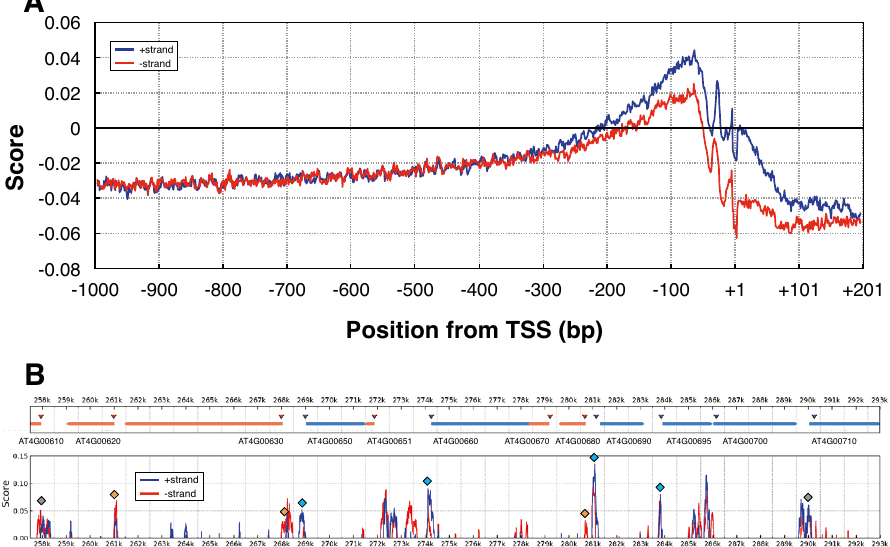
Figure 3. PRI along the promoter region. ( A ) Average of 21,393 Arabidopsis promoters for protein-coding genes for both strands (+ and −). ( B ) A part of Chr 1 is scanned with PRI. Upper panel shows gene models (blue = forward, red = reverse). Intron–exon information is omitted. Triangles at the head of each gene model show the position of the Genic Top TSS. Lower panel shows PRI scores. Scores were subjected to smoothing with a bin of 151 bp width. Negative scores are no shown. PRI peaks corresponding to actual TSS are shown by rhombuses (blue = forward, red = reverse).